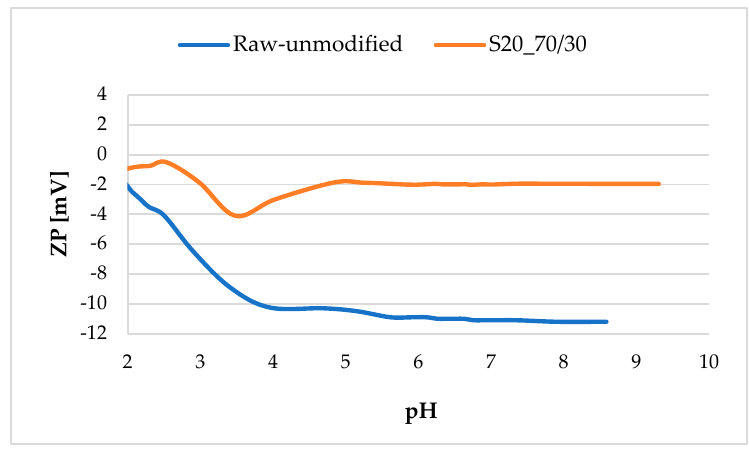
Figure 9. ζ -potential of raw unmodified and S20_70/30 rice husks plotted as a function of pH.